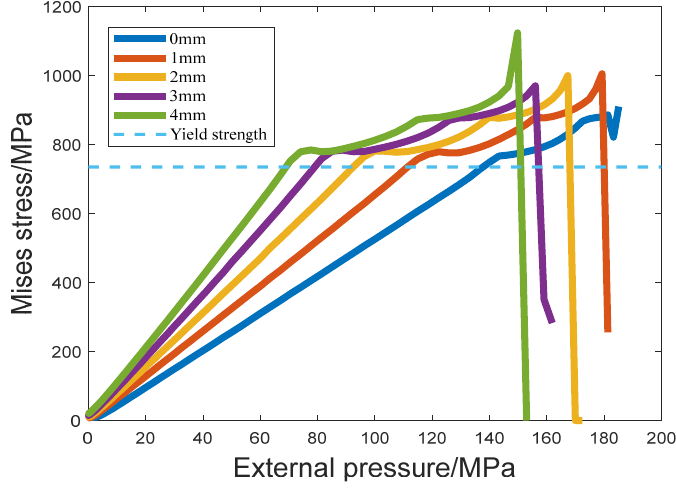
Figure 5. Curve of stress variation with load at node A1.